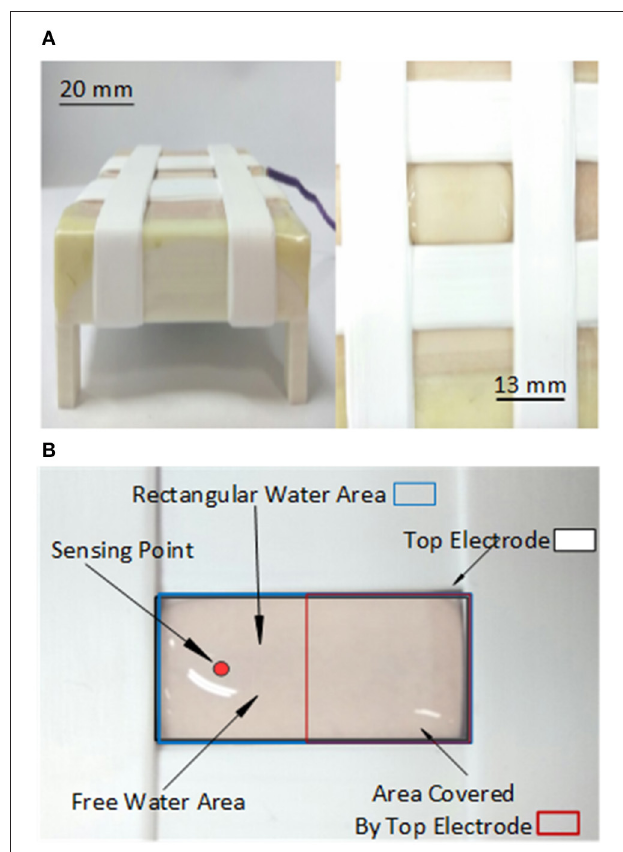
FIGURE 2 | Electrically actuated water droplet actuator system (A) Images of actual System. (B) Detailed top view of a water